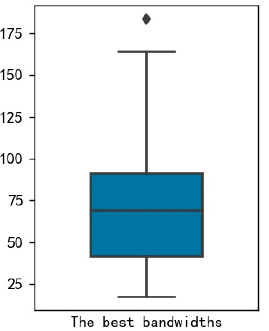
Figure 9. Optimal range of the bandwidth.